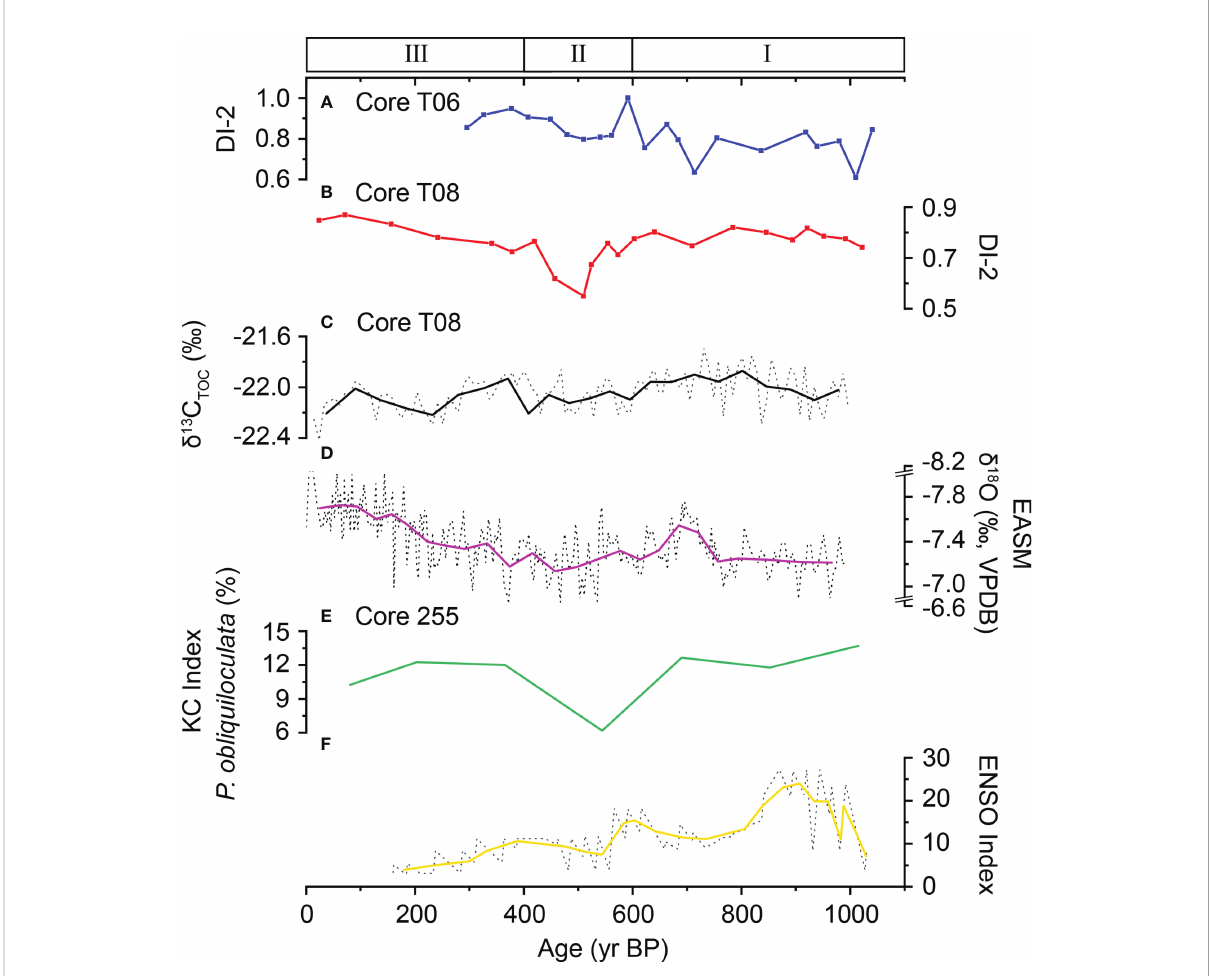
FIGURE 3 Records of DI-2 values in cores T06 and T08 and other environmental indicators over the past 1000 years: (A) DI-2 proxy record from core T06; (B) DI-2 proxy record from core T08; (C) d 13 C TOC record from core T08, the solid line indicates a 5-point average (Wu et al., 2018); (D) EASM record reconstructed from oxygen isotope ratios ( d 18 O) of stalagmites in Dongge Cave, the solid line indicates a 10-point average (Wang et al., 2005); (E) Holocene KC index from the Northwest Paci fi c reconstructed from the abundance of the KC indicator Pulleniatina obliquiloculata in core 255 (Jian et al., 2000); and (F) ENSO index over the last millennium based on the event model, the solid line indicates a 5-point average (Moy et al.,